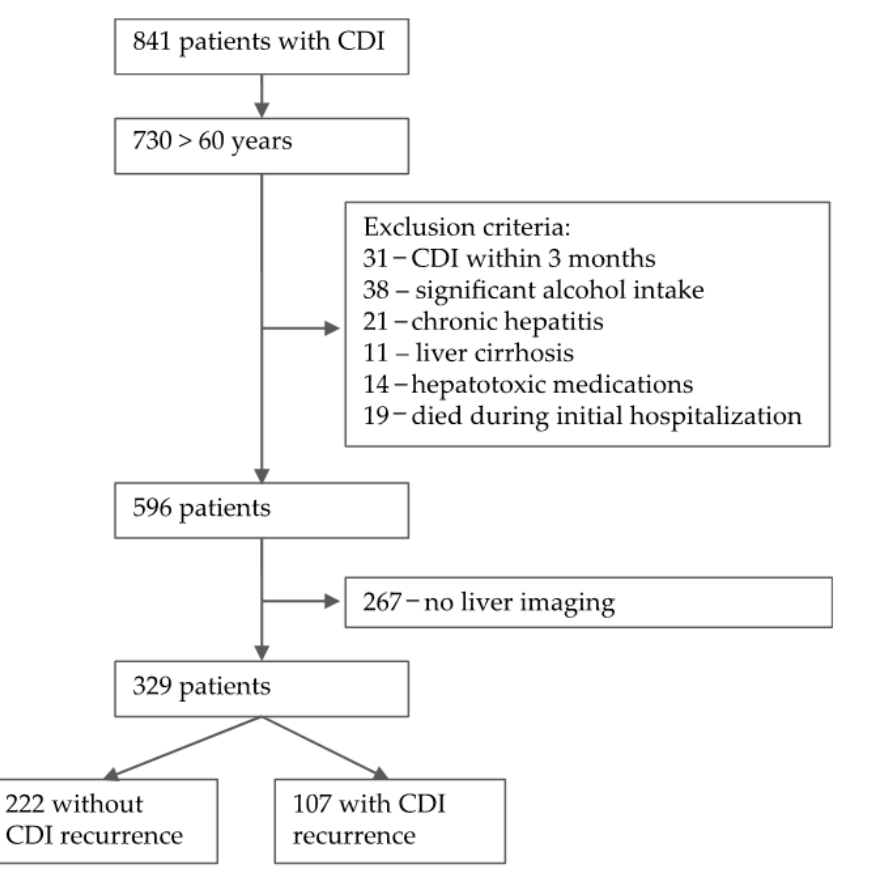
Figure 3. Study design flow